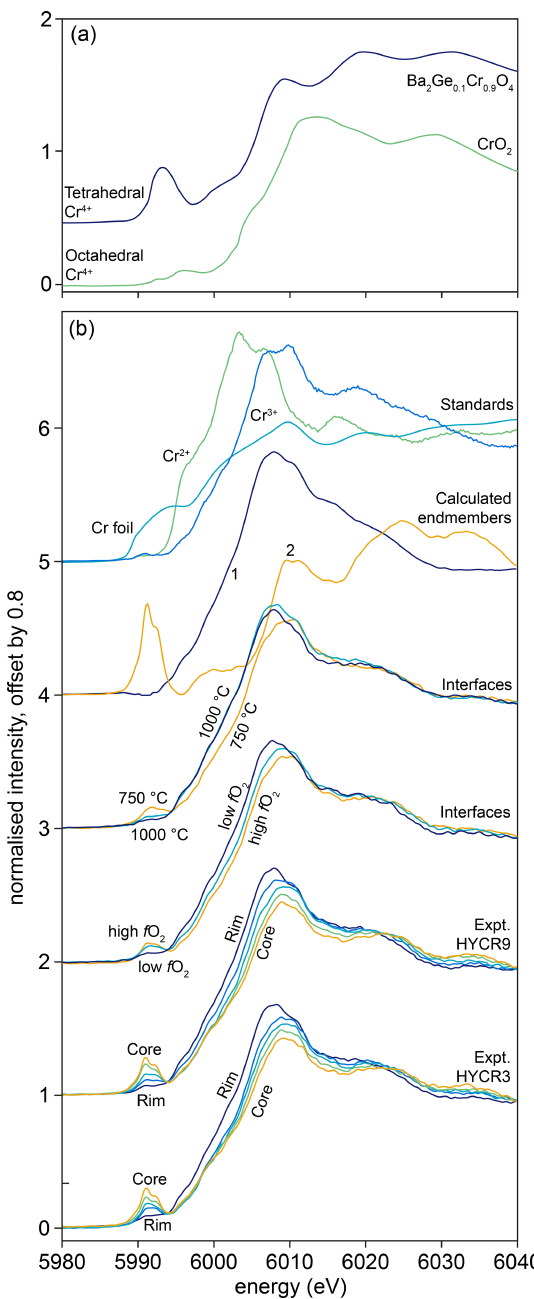
Figure 2. Cr K-edge XANES spectra of Cr 4 + -bearing compounds (CrO 2 and Ba 2 Ge 0 . 1 Cr 0 . 9 O 4 ) from Pantelouris et al. (2004). Note the intense pre-edge feature associated with tetrahedral Cr 4 + ; 12.6eV has been added to the energy values from Pantelouris et al. (2004), determined by approximating the difference between the position of the first derivative of their Cr metal spectrum (their Fig. 8) and 5989.2eV (the energy calibration of the monochromator in our study). These spectra are not appropriate for use as standards in our study given that the Cr has a different coordination environment. (b) XANES spectra from experimental samples and standards. (a) Cr metal, Cr 2 + and Cr 3 + in pure forsterite from Jollands et al. (2018). Calculated end-member spectra (marked “1” and “2”). “Interface” spectra were acquired 5µm from the true interface. The upper spectra marked “interfaces” were from 1.5GPa samples, fo-en and Ni–NiO, at 750, 850 (unmarked) and 1000 ◦ C. The next set is for samples from 1.5GPa experiments, fo-en, 850 ◦ C. Low f O 2 : graphite, high: Ag–Ag 2 O, intermediate curve: Re– ReO 2 . Also shown are some spectra from samples HYCRa9 (24h, 850 ◦ C, Ni–NiO, zrc-bdd) and HYCRa3 (12h, 850 ◦ C, Ni–NiO, fo-en), both showing core-to-rim variations in the pre-edge feature intensity, the edge position, and position of the white